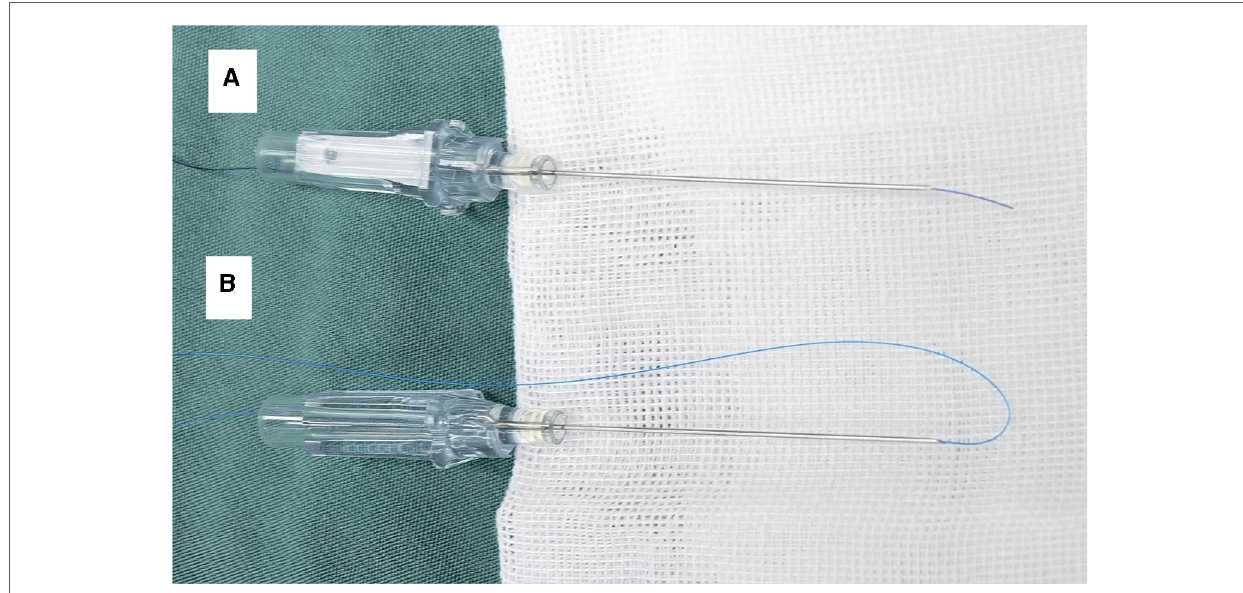
FIGURE 1 Needle and suture were prepared: ( A ) suture #1 (4-0 medtronic absorbable suture) was placed in a 22-gauge indwelling needle, and the tip of the suture #1 was slightly exposed to the bevel of the needle; ( B ) suture #2 (5 – 0 prolene suture) was placed in a 22-gauge indwelling needle, and a loop was formed at the front